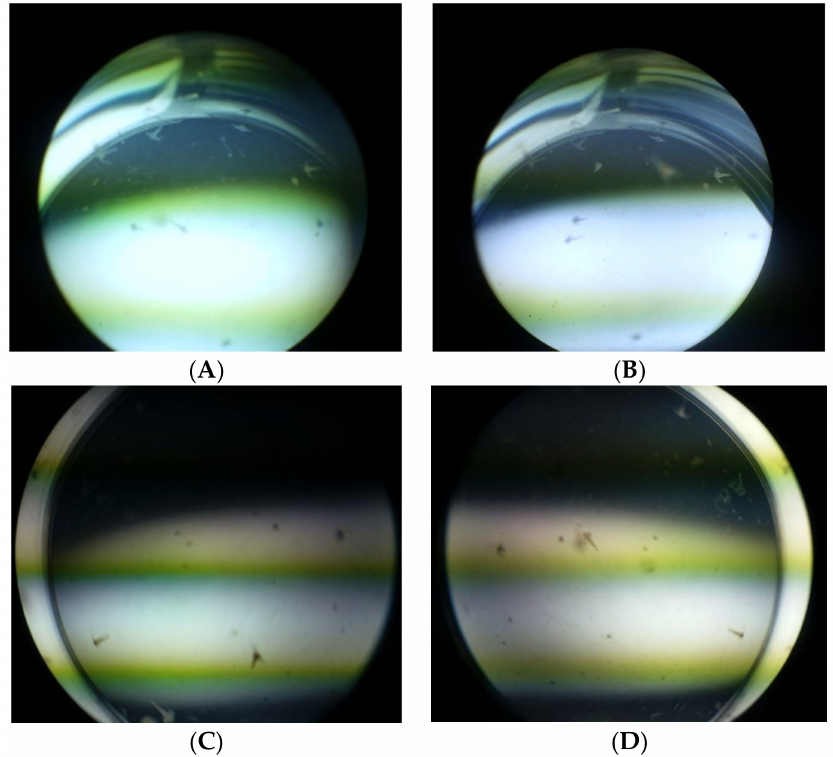
Figure 2. Brine shrimp lethality at 24 h in a 24-well plate: ( A ) potassium dichromate (1000 µ g/mL);